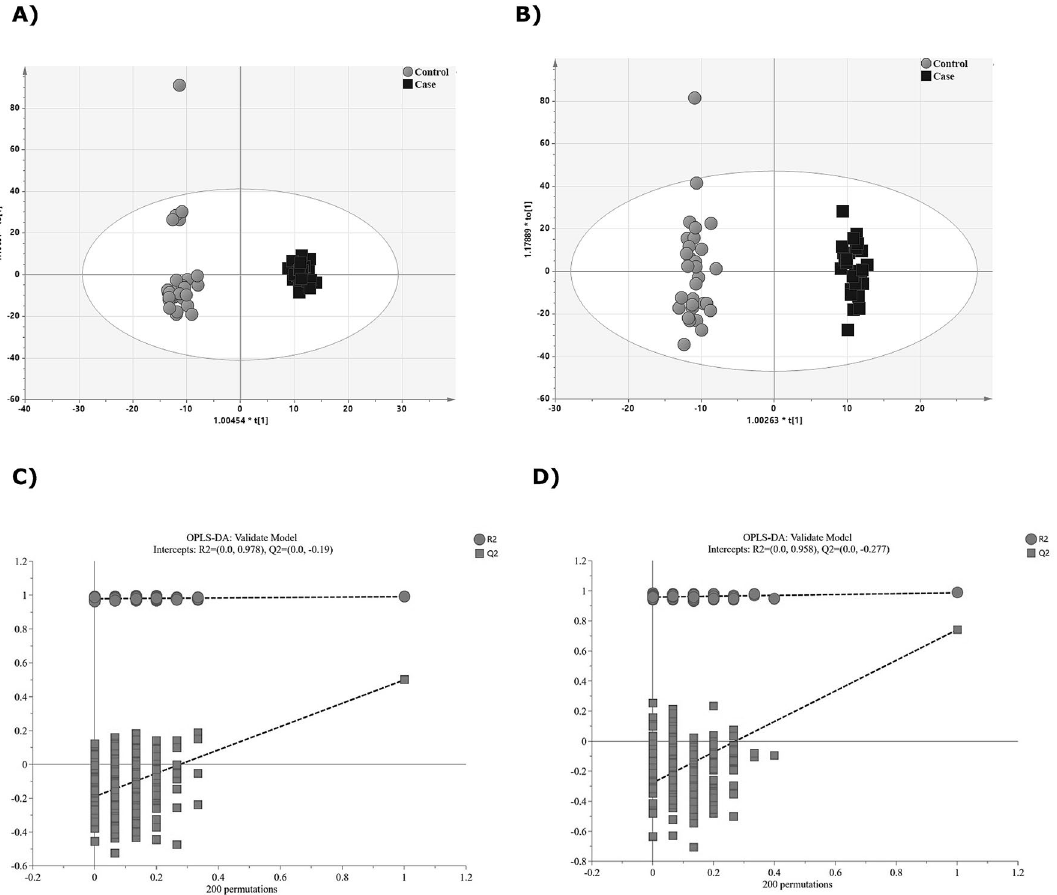
Figure 1. Discriminant analysis of groups NC-AME patients vs. control group. ( A ) OPLS-DA score scatter plots in ESI negative mode. X-axis and Y-axis represent score vectors summarizing all the variables entering the analysis. ( B ) Scatter plot of OPLS-DA in ESI positive data. ( C ) Validation plot for OPLS-DA model in ESI negative mode. A 200-time permutation test was used to assess the model. The y-axis intercepts were R2 (0.0, 0.978) and Q2 (0.0, − 0.19). ( D ) Validation plot for OPLS-DA model in ESI positive mode. The permutation tests were carried out with 200 random permutations. The y-axis intercepts were R2 (0.0, 0.958) and Q2 (0.0, −